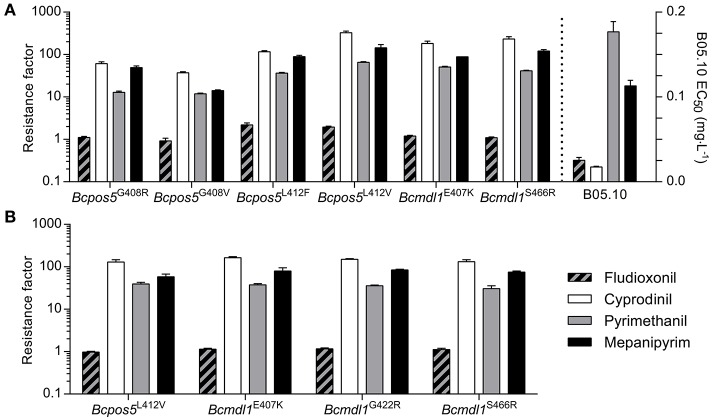
Cross-resistance profiles of a collection of isolates including the most prevalent AP resistance mutations from the field and available corresponding homologous recombinants. Resistance factors were calculated relative to the reference strain B05.10. Sensitivity to FDL was tested to confirm the absence of MDR1/3 (multidrug resistance) phenotypes. (A) Individual single spore isolates with Bcpos5 and Bcmdl1 genotypes confirmed by Sanger sequencing. Bcpos5G408R: 14-BC-183s, Bcpos5G408V: 11-BC-060s, Bcpos5L412F: 09Bc11, Bcpos5L412V: 14-BC-007s, Bcmdl1E407K: 14-BC-020s, Bcmdl1S466R: 10-BC-041s (see Table S2). Mean values of technical triplicates ± standard deviation of one isolate per mutation are shown. (B) Homologous recombinants, mean values of three transformants per genotype ± standard deviation are shown. Individual transformants were tested in technical triplicates.